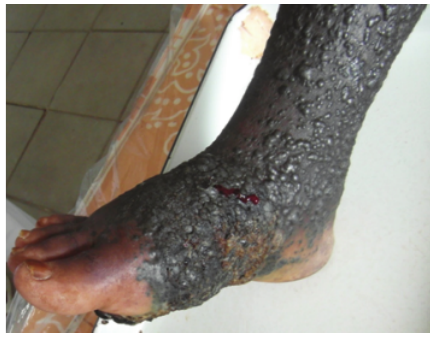
Figure 2: Cutaneous in-transit metastasis of a nodular melanoma of the right foot.